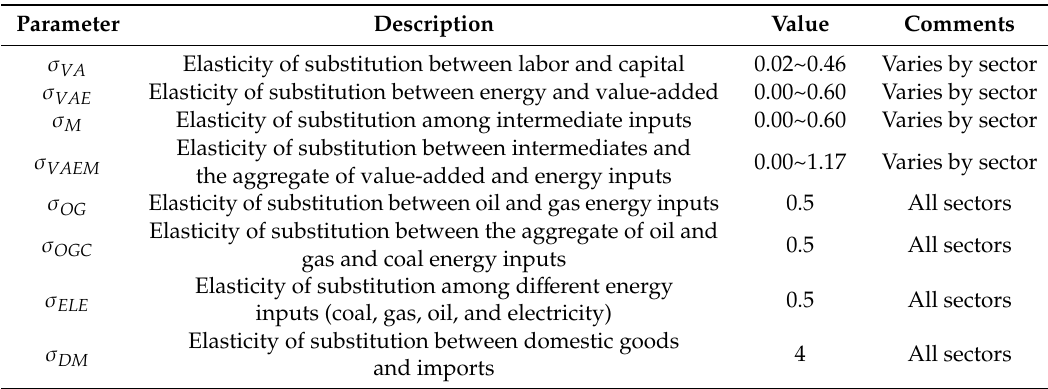
Table 2. Key parameters in the model.